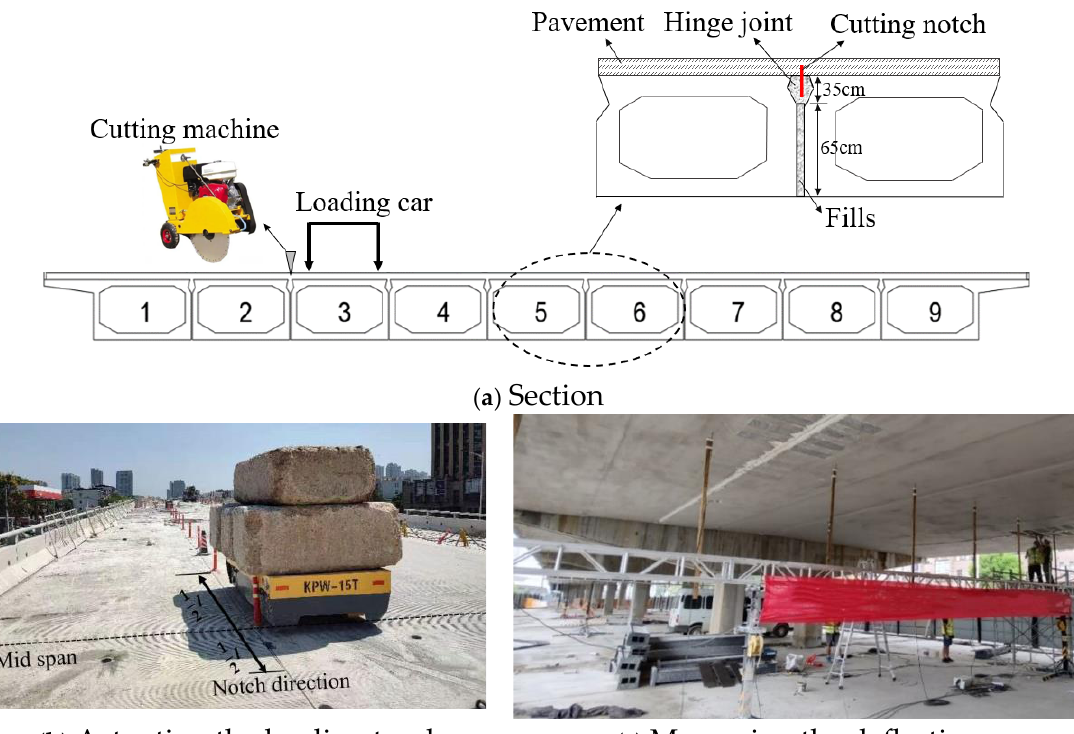
Figure 8. The destructive experiment.